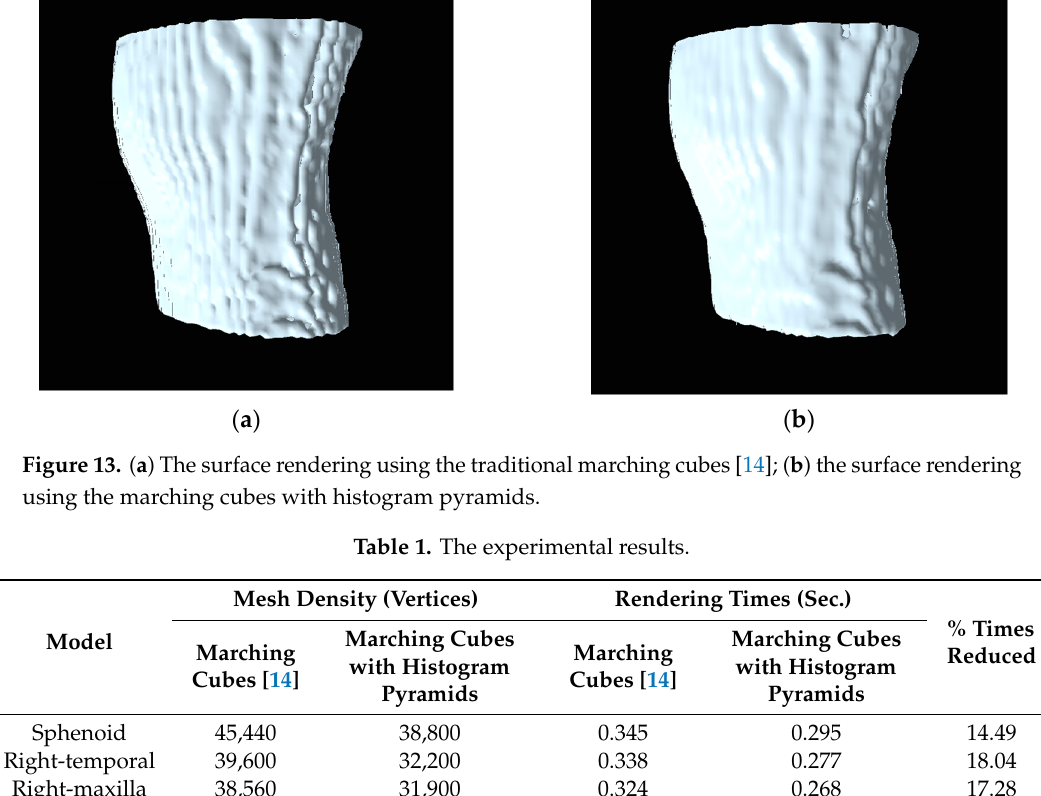
Table 1. The experimental results.